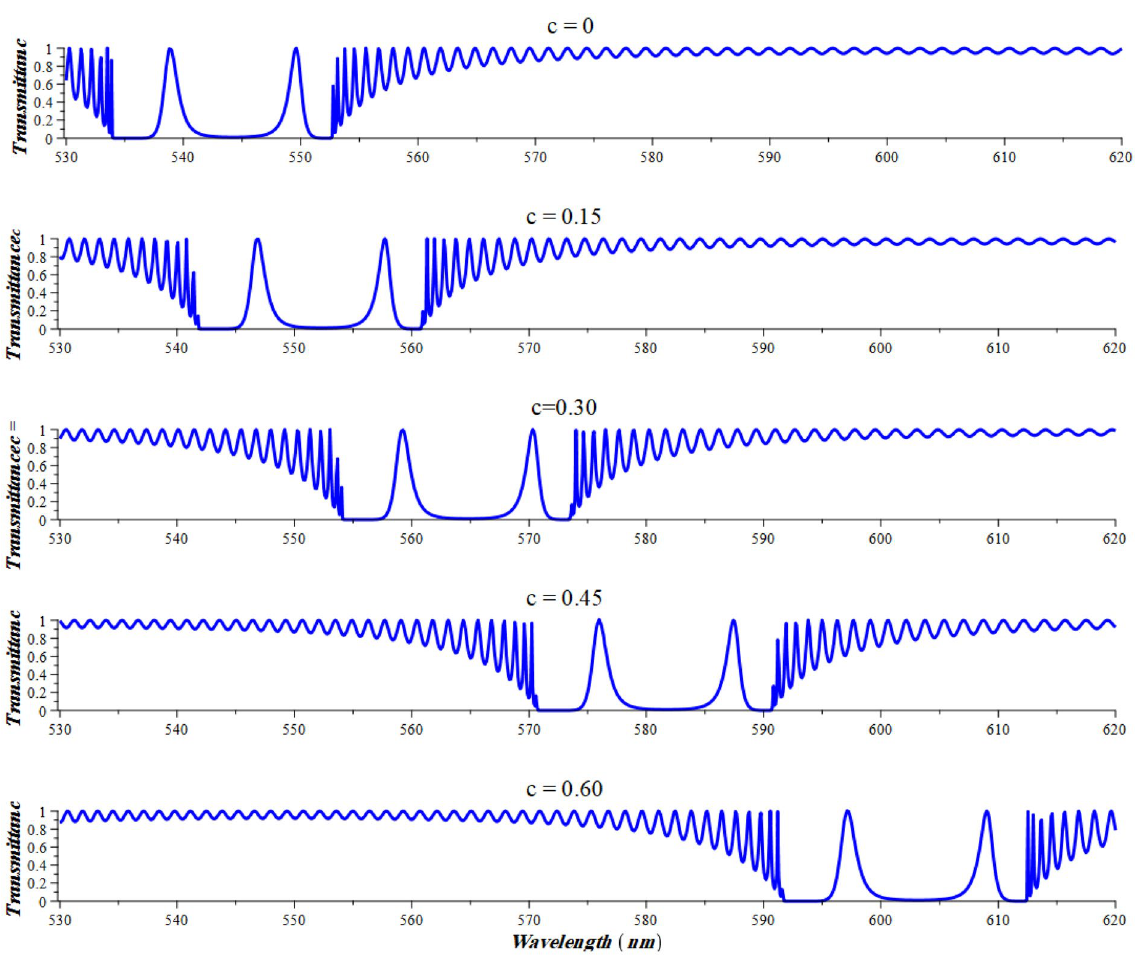
Figure 8. transmittance spectrum of the proposed structure operating at two-split-peaks region. N = 70, ∧ = − 20 × 10 −6 relative to the different concentrations of NaI.